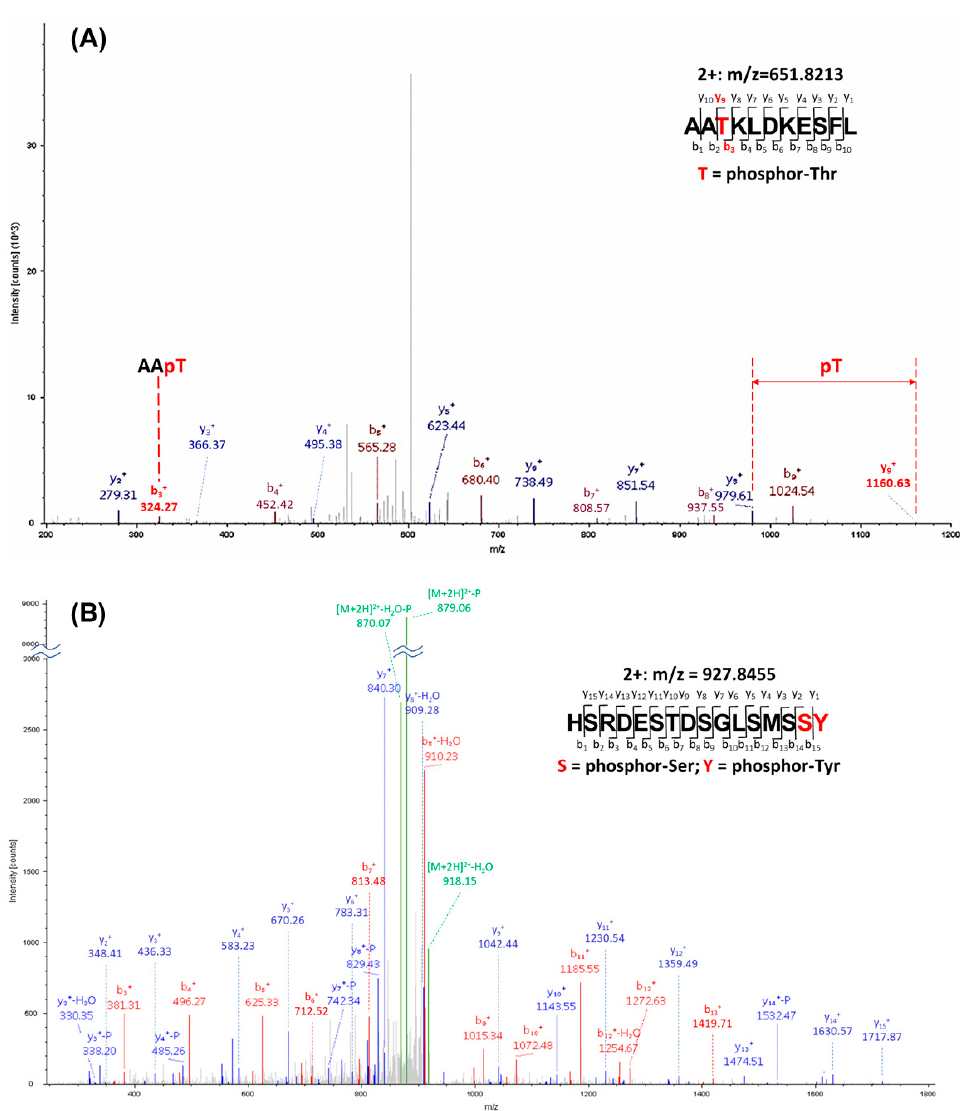
Figure 4. MS / MS spectra demonstrating the phosphorylation sites at T493 ( A ) and S406 / Y407 ( B ) as Figure 4. MS/MS spectra demonstrating the phosphorylation sites at T493 ( A ) and S406/Y407 ( B ) as examples of LC–MS / MS examples of LC–MS/MS determinations.